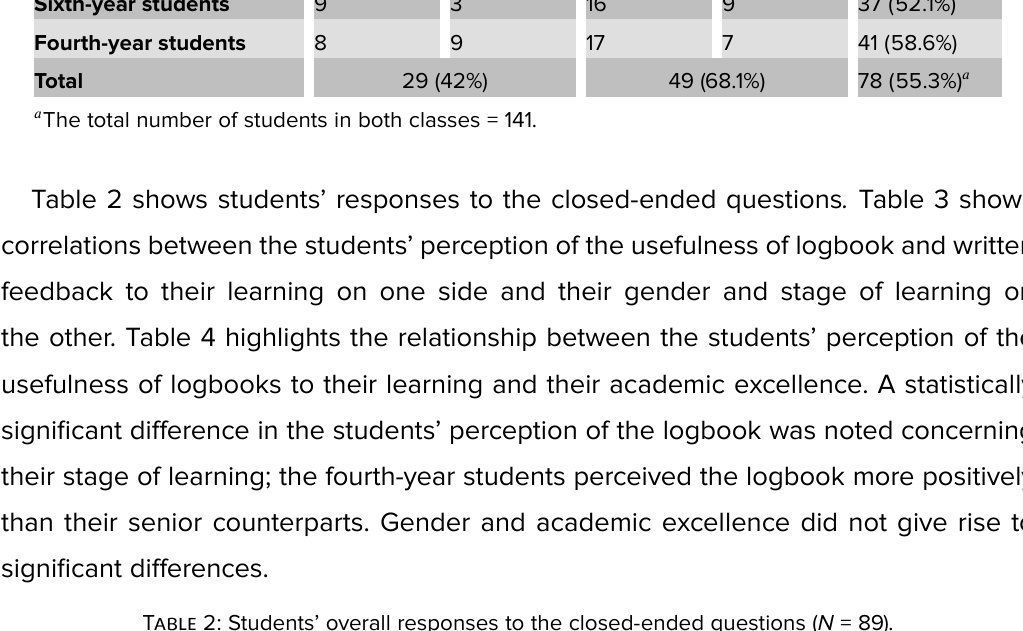
TABLE 2: Students’ overall responses to the closed-ended questions ( N =